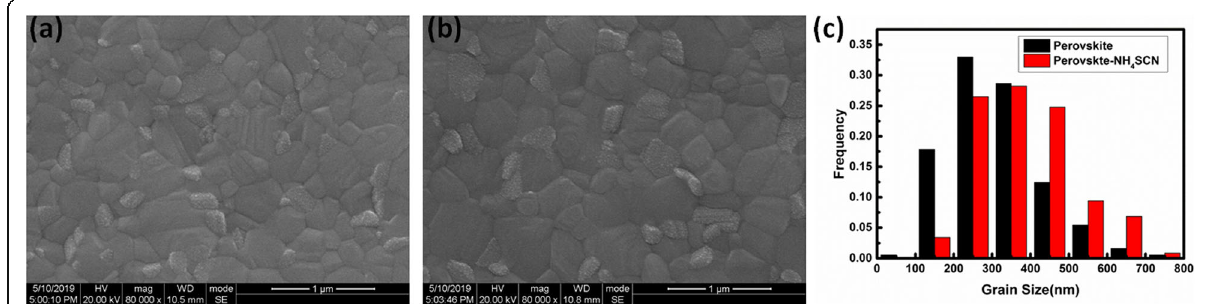
Fig. 4 a , b Surface SEM image of perovskite-w/o-NH 4 SCN films ( a ) and perovskite-NH 4 SCN films ( b ). c Histogram for grain-size distribution of the crystals in surface SEM